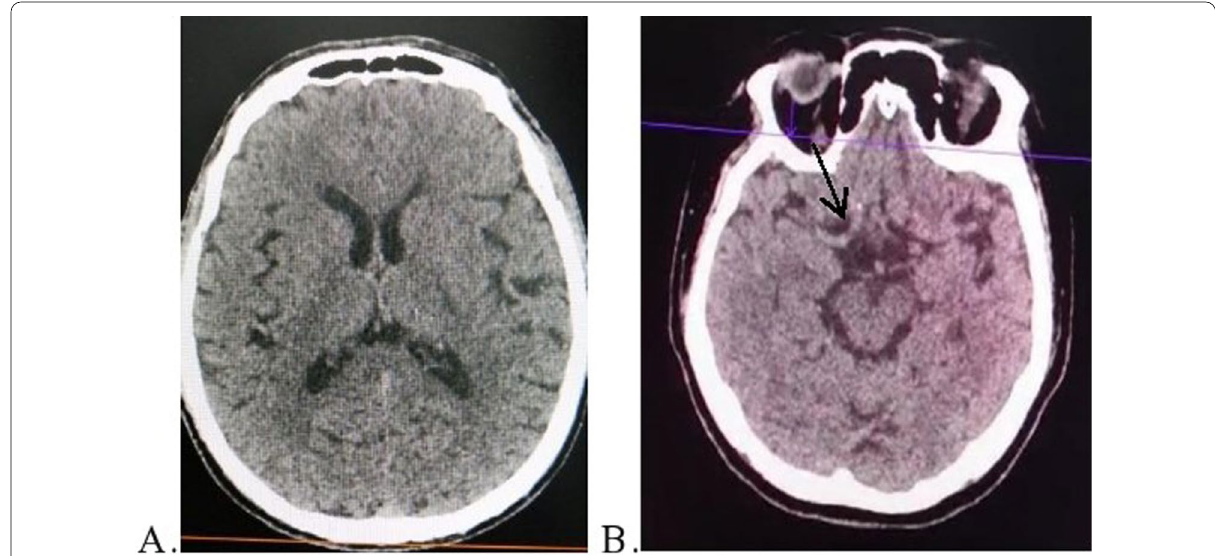
Fig. 1 Imaging of ischemic stroke patients with COVID-19. A CT brain from case 1, showing hypodensities in left ganglia basal, insula and internal capsule. B Case 2, hypodensities were not found, MCA dense sign were prominent (black arrow). MCA middle cerebral